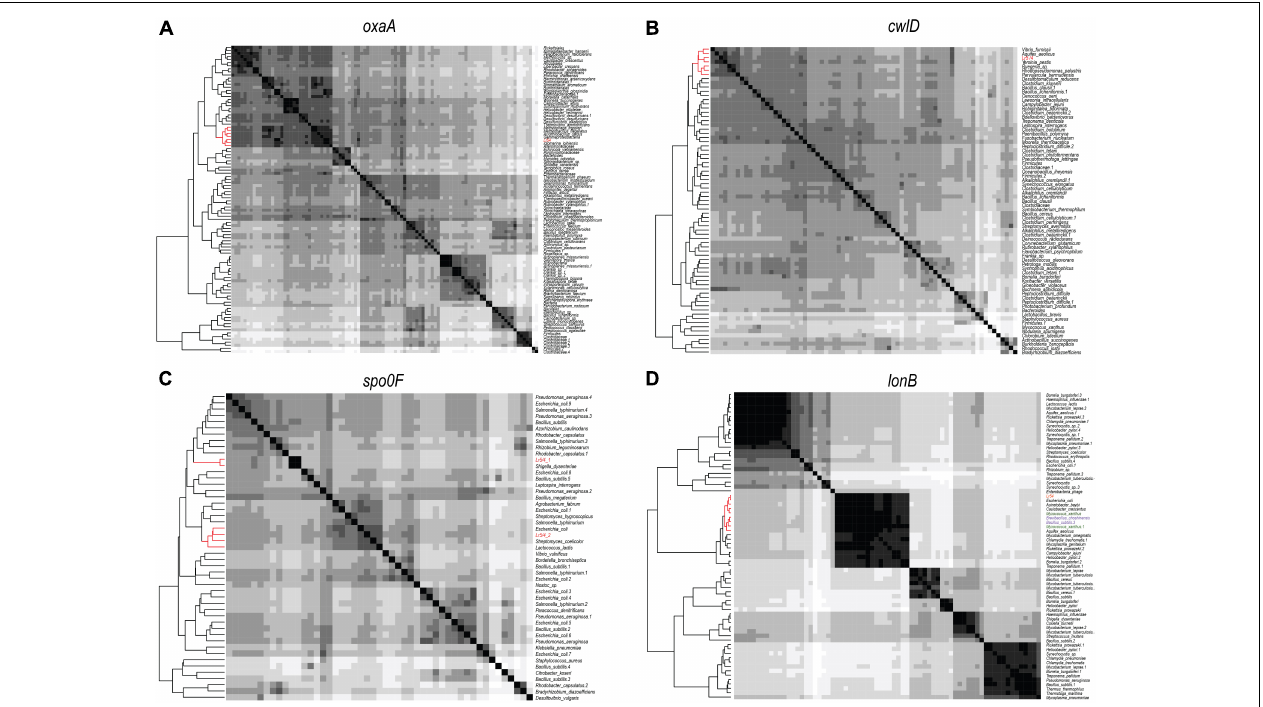
FIGURE 4 | Heatmaps showing the phylogenomic neighborhood for four genes related to sporulation found in the genome of S. ureilytica Lr5/4 (highlighted in red). In panels (A–C) , the highest similarity for the sporulation genes lies with phylogenetically closely related taxa (indicated in red). This was true for 25 genes. In panel (D) , the only exception is shown. Homologs of the lonB gene are more similar between species from distant phyla, than from species of the same phylum. Strain Lr5/4 has a lonB gene that is found to bear closer similarity to its homolog in Myxococcus (green) and Bacillus (purple), rather than to homolog genes in γ -Proteobacteria.